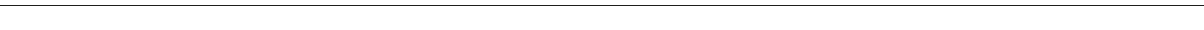
Fig. 2 DAPK2 is phosphorylated on Ser289 upon AMPK activation. a HCT116 cells were transfected with FLAG-DAPK2 WT, S289A or empty vector and treated with 5 mM/10 mM phenformin or DMSO for 4 h. b HCT116 cells were transfected with FLAG-DAPK2 WT and treated with 250 μ M resveratrol for 2/3 h. c HCT116 cells were transfected with FLAG-DAPK2 WT and treated with 100 μ M A-769662 for 1/2/4 h. d A549 cells were transfected with FLAG- DAPK2 WT, S289A or empty vector and treated with 5 μ M ionomycin for 2 h. e A549 cells were transfected with FLAG-DAPK2 and treated with 10 μ M ionomycin or DMSO for 1 h, with or without the addition of 5 μ M compound C. f Mice were fasted for either 24 or 48 h, or fed normally, as control. Muscle tissue from three different mice at each condition was extracted and protein lysates were subjected to western blots. g HCT116 cells were transfected with FLAG-DAPK1 and treated with 200 µ M resveratrol for 2 h or serum-starved overnight and then treated with 100 nM PMA for 30 min. Anti-FLAG immunoprecipitates were resolved by SDS – PAGE. DAPK1 Ser289 phosphorylation was monitored using an antibody that recognizes the sequence RXRXXpSer/Thr, which was previously shown to speci fi cally detect phosphorylation of DAPK1 on Ser289 38 . In all panels, experiments were repeated three times and representative immunoblots are